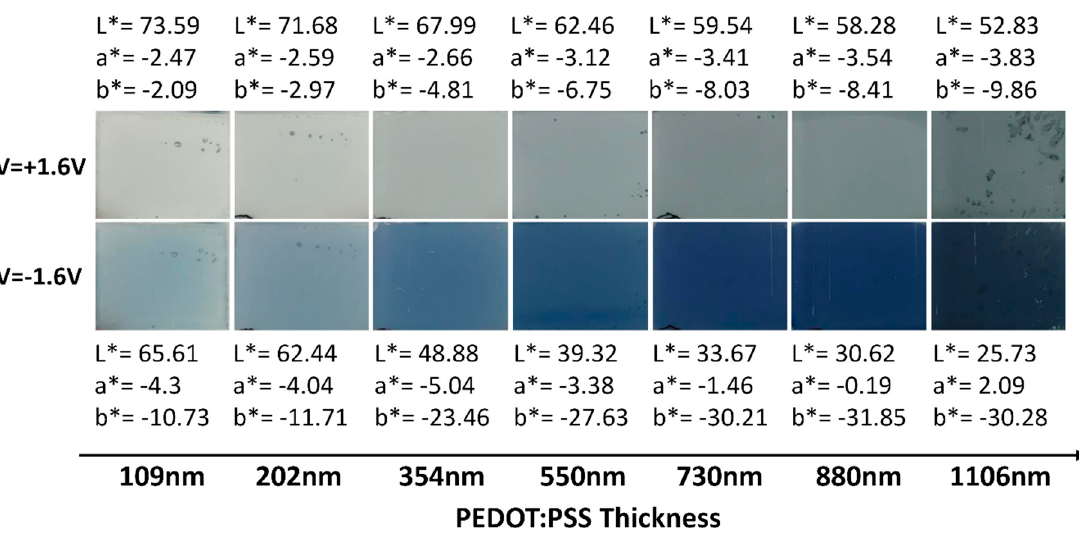
Figure 2. Photographs of the electrochromic symmetrical displays built from PEDOT:PSS films with different thicknesses, showing an oxidized state for a potential of +1.6 V and a reduced (colored) state for a potential of − 1.6 V. The corresponding measured L*a*b* parameters are mentioned at the top and bottom of the image for the oxidized (bleached) state and the neutral (colored) state, respectively.